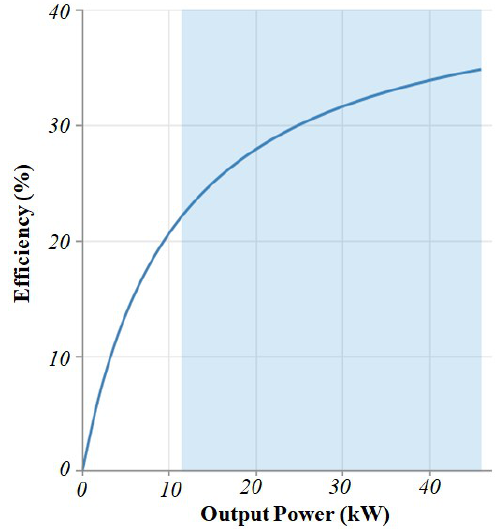
Figure 12. Efficiency characteristics of diesel generator.